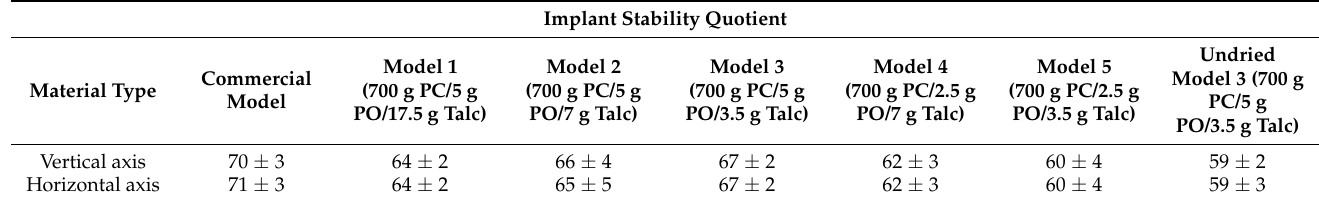
Table 4. Results of the stability measurement of the VXI300 implant in the tested materials. The implant stability quotient was made for each model tested and for model No. 3 in the undried version. Readings in the horizontal and vertical axis were made for 15 implant anchors in each of the tested models. Stability results were averaged for each material